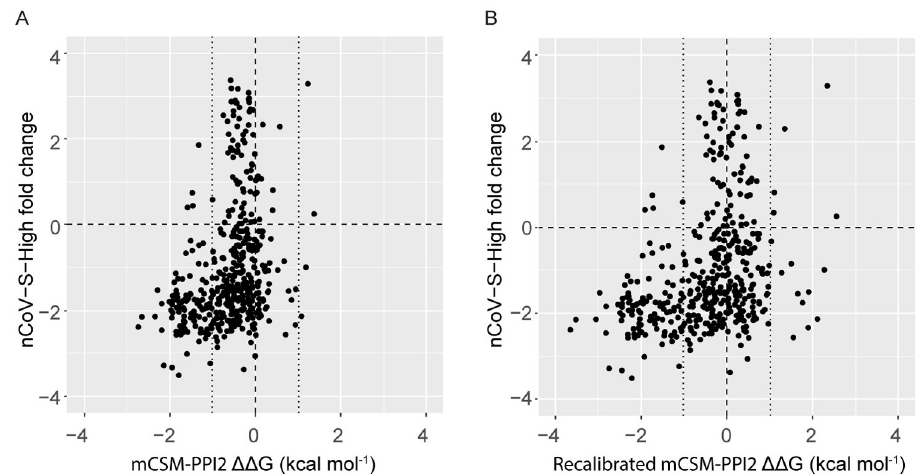
Fig 5. mCSM-PPI2 predicted ΔΔ G with and without recalibration are in agreement with published deep mutagenesis binding data [22] at low predicted ΔΔ G but recalibrated predictions are more sensitive towards variants that increase binding. ACE2 mutant binding to Spike RBD relative to ACE2 WT determined via a deep mutagenesis protocol vs. A. mCSM-PPI2 predicted ΔΔ G and B. recalibrated predicted ΔΔ G for all 437 possible ACE2 mutants at the 23 sites within 5 Å of Spike RBD. The dotted lines highlight predicted ΔΔ G ± 1 kcal mol -1 . The overwhelming majority of predictions by mCSM-PPI2 below this range also show reduced binding in the deep mutagenesis binding data, suggesting mCSM-PPI2 is specific for mutants that significantly lower binding, in agreement with our previous determination using a different dataset [23]. Within ± 1 kcal mol -1 , the deep mutagenesis assay finds variants that increase and lower binding and whilst the original mCSM-PPI2 predictions predicts most of these to lower binding, the recalibrated predictions correctly reflect the ambiguity by centring these variants at predicted ΔΔ G = 0 kcal mol -1 . Above this range (i.e., > 1 kcal mol − 1 ), where variants are predicted to enhance binding, a higher proportion of the recalibrated predictions also show enhanced binding in the deep mutagenesis data (5/17) compared to the raw mCSM-PPI2 prediction (2/5). Figure generated with R